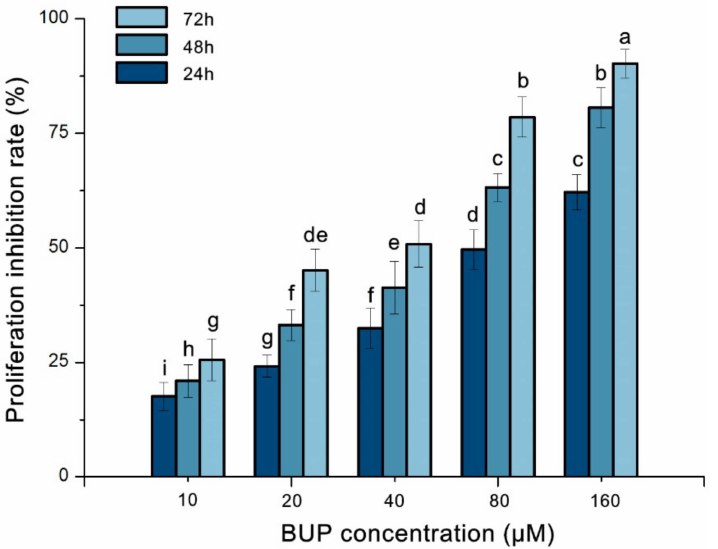
Figure 1. Cytoactivity of buprofezin (BUP) against A549 cells at various concentrations for various lengths of time. Different lowercase letters above columns indicate statistical differences from each other at p ≤ 0.05. Columns with the same letters are not significantly